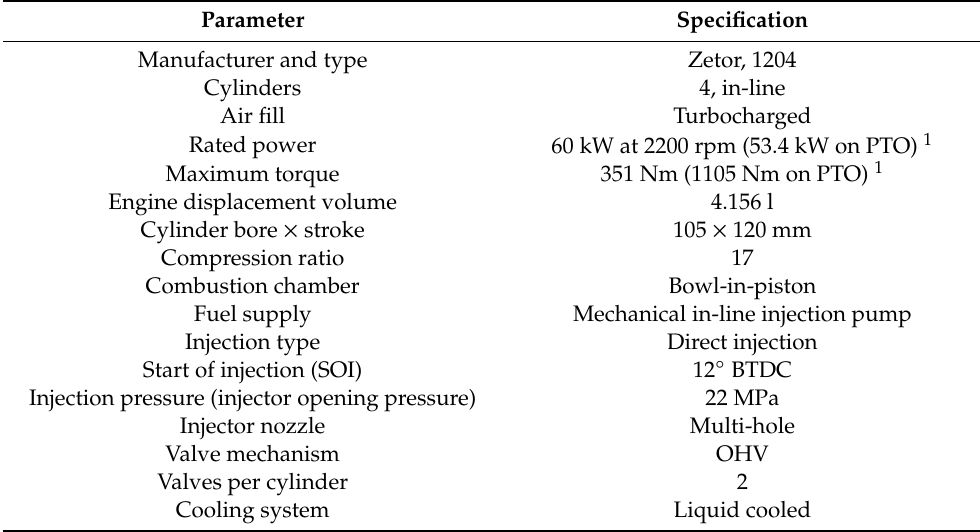
Table 3. Engine specification (power take o ff —PTO).